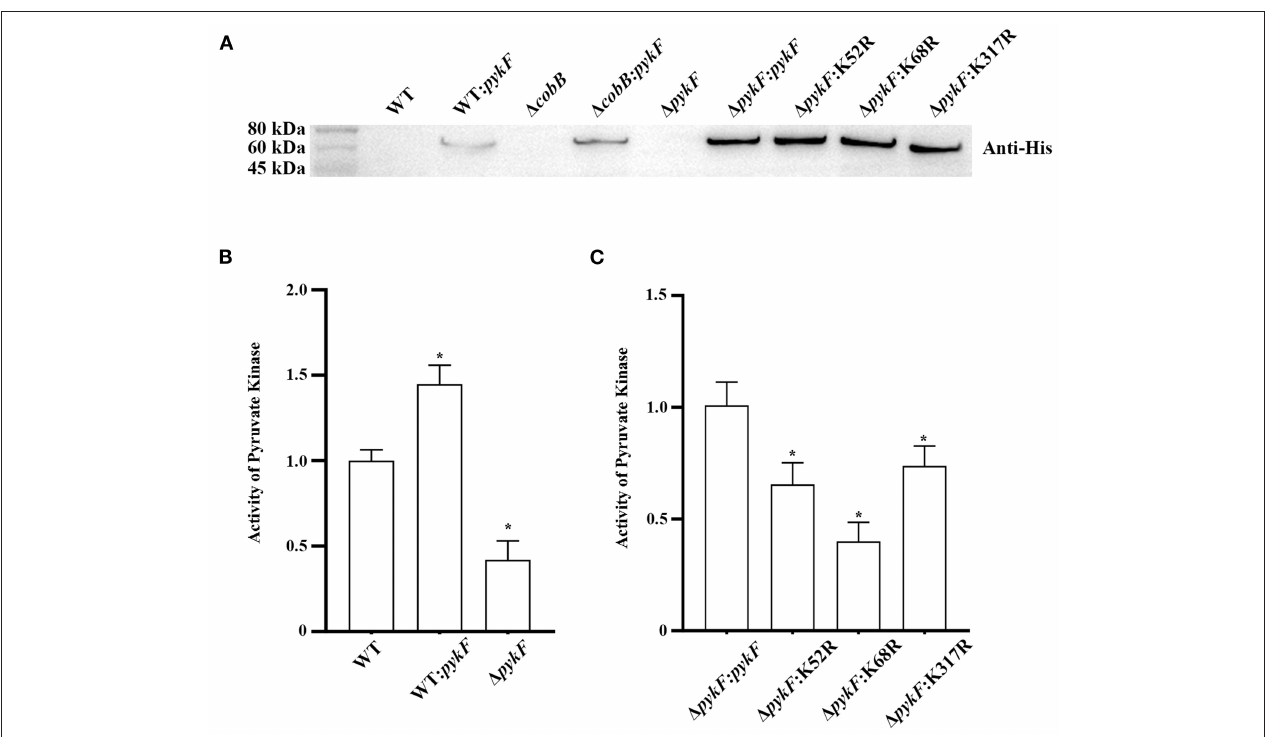
FIGURE 2 | (A) Construction of complemented and overexpression strains. Lane 1, wild-type (WT); Lane 2, WT: pykF overexpression strain; Lane 3, deletion of cobB gene strain ( 1 cobB ); Lane 4, 1 cobB : pykF complemented strain; Lane 5, deletion of pykF gene strain ( 1 pykF ); Lane 6, 1 pykF:pykF complemented strain; Lane 7, 1 pykF :K52R complemented strain; Lane 8, 1 pykF :K68R complemented strain; Lane 9, 1 pykF :K317R complemented strain. Anti-His: His Tag Mouse Monoclonal Antibody. (B) Analysis of pyruvate kinase activity throughout the V. alginolyticus 1 pykF strain and WT: pykF overexpression strain. Pyruvate kinase activity of